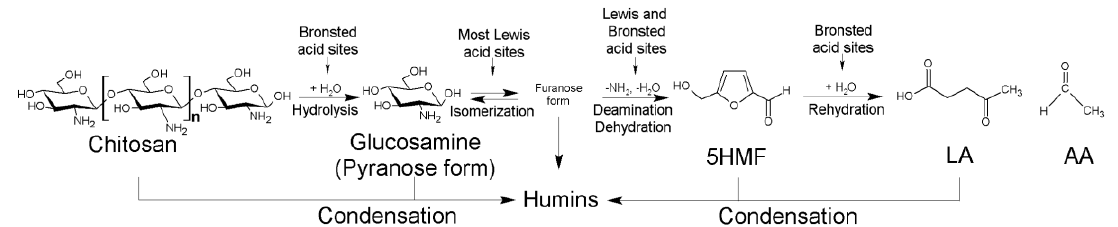
Figure 27. Scheme for the production of HMF and LA from chitosan.